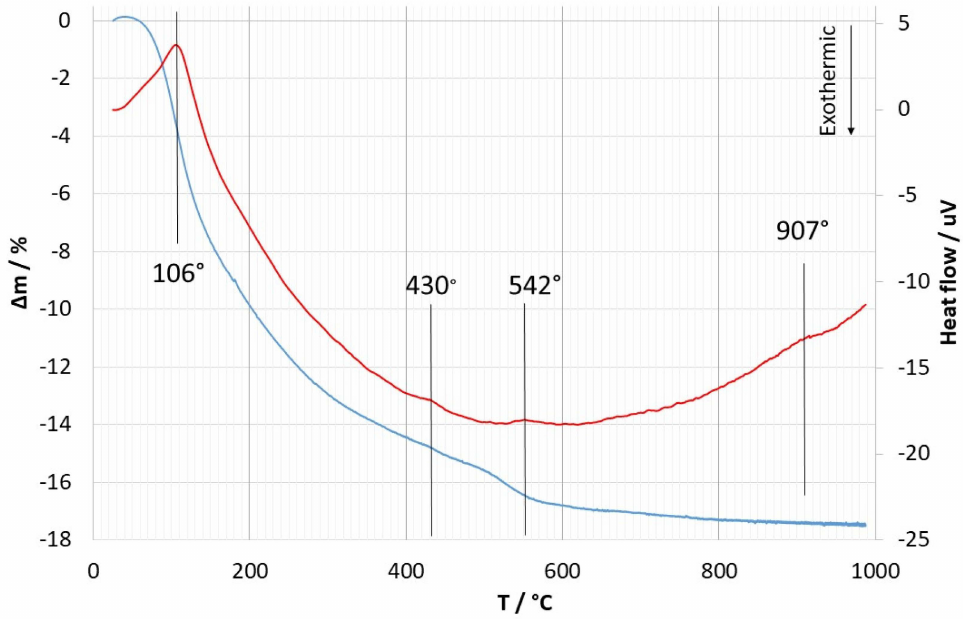
Figure 2. TGA and DTA curves of the coating material.